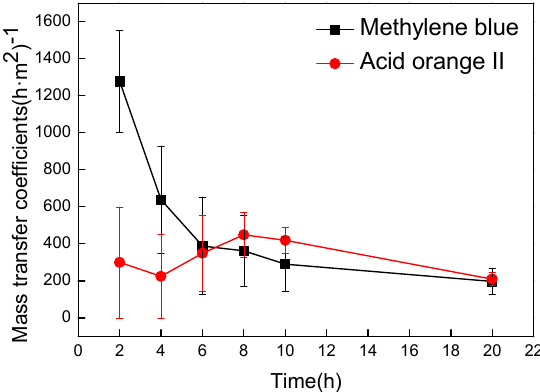
Figure 4. Effect of substance surface charge on transmembrane mass transfer.